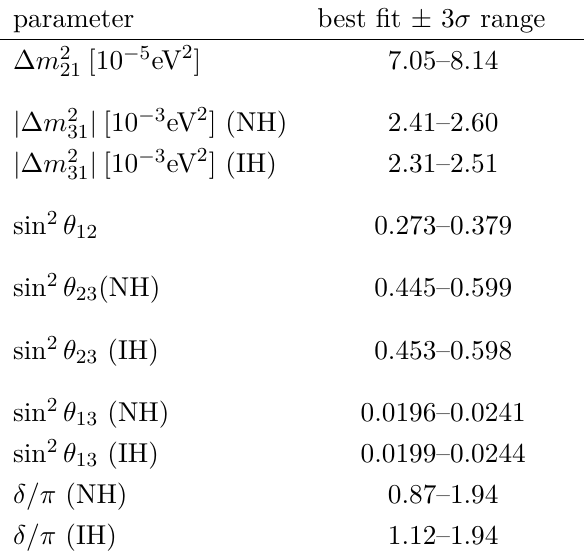
Table 4 . Neutrino oscillation parameters summary determined from the global analysis [134].